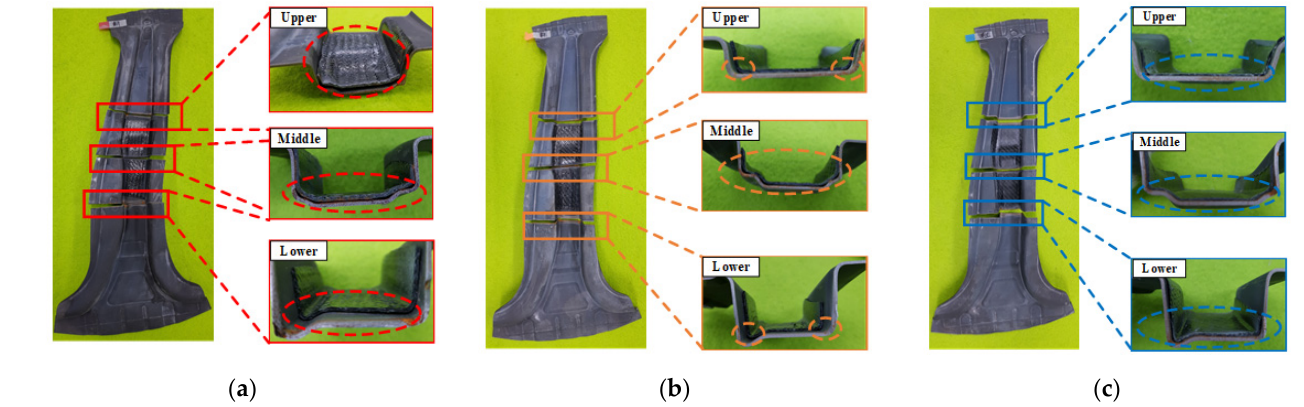
Figure 15. The cross-sectional observation according to various tool temperatures. ( a ) 90 °C. ( b ) 110 °C. ( c ) 130 °C.